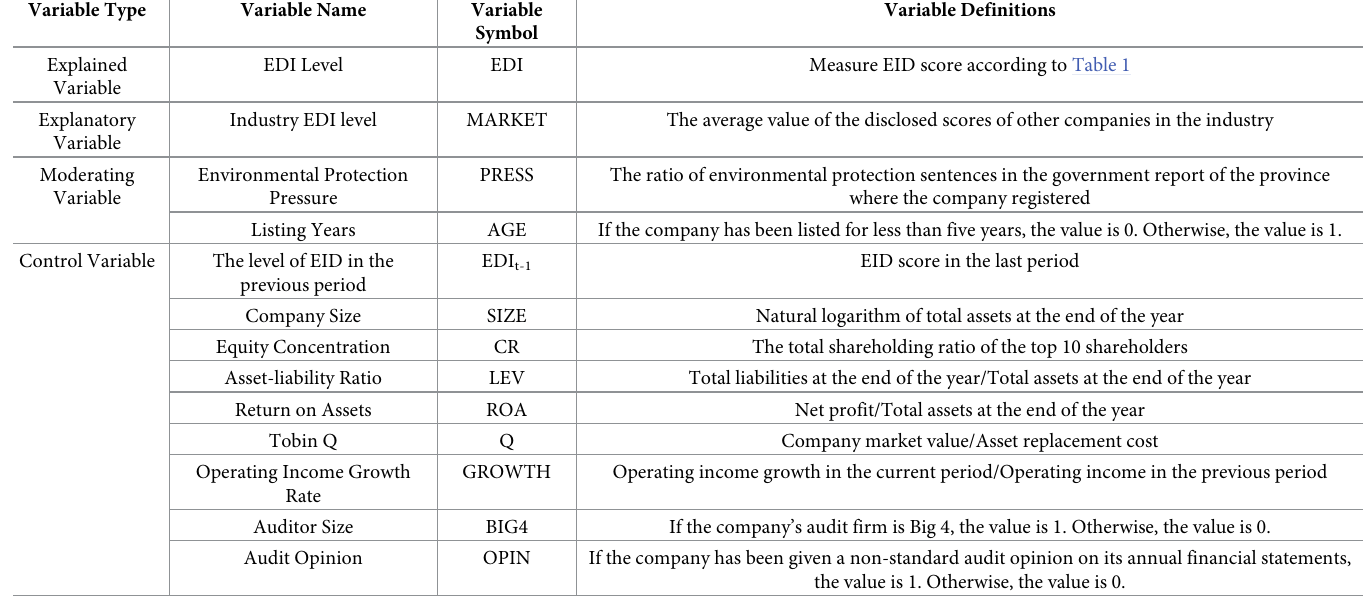
Table 2. Summary table of